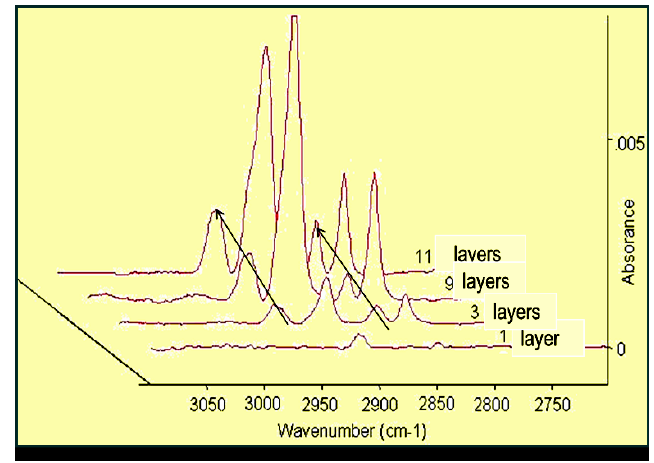
Figure 3. IRRAS spectra of LB nanolayers of stearoyl hydroxamic acid deposited onto copper [69]. Progress in Colloid Polymer Science, Springer, Heidelberg, 2008 (copyright licensed by the Springer Nature).